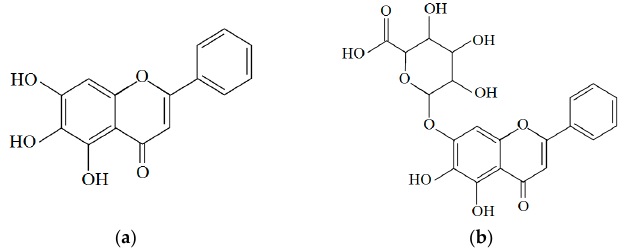
Figure 4. Structures of two bioactive components in Scutellaria baicalensis : ( a ) Baicalein, ( b ) Baicalin.